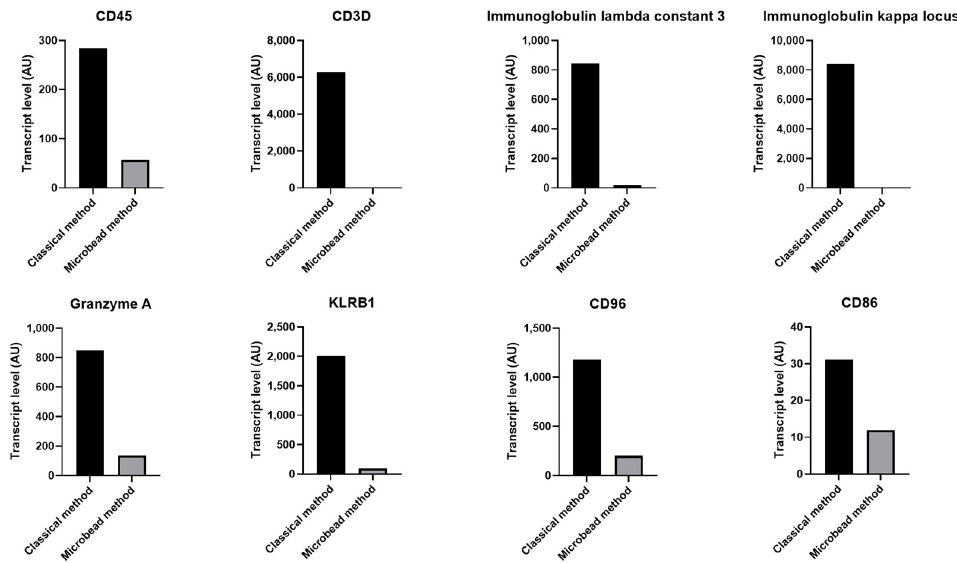
Figure 3. Stronger presence of transcripts related to leukocytes in platelets purified without magnetic microbeads. Histograms presenting transcript levels for a number of leukocyte genes, detected by microarray in platelet preparations purified with or without magnetic microbeads. Data were analyzed using RMA algorithm and TAC software. Different transcript levels with a fold change higher than 2 or lower than − 2 were retained.